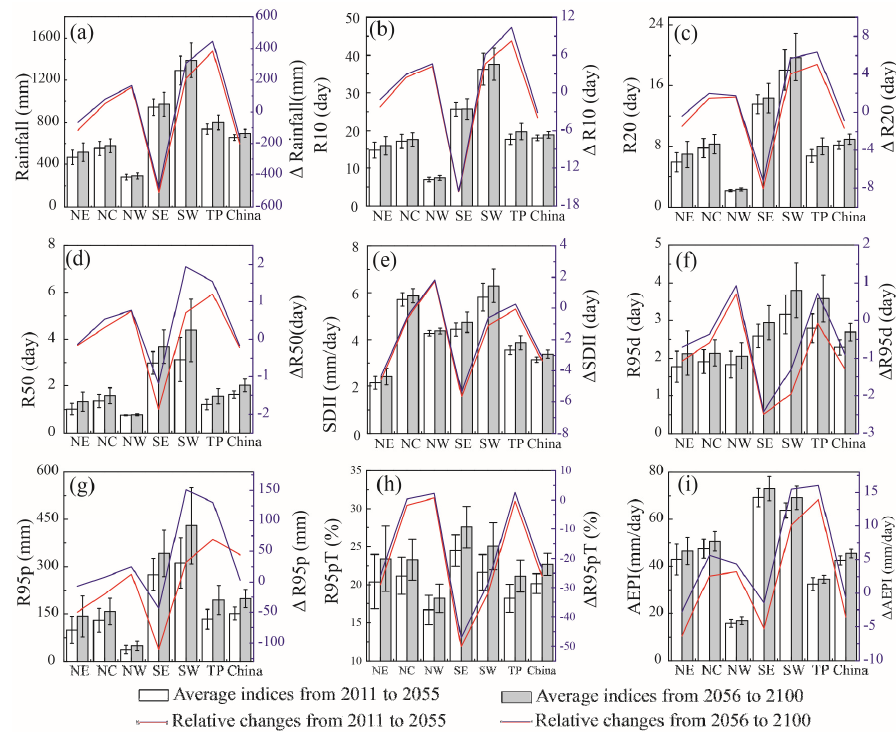
Figure 5. Annual average extreme precipitation indices in the next 90 years and the relative changes respect to the past 58 years (1960–2017) in China: ( a ) annual average rainfall, ( b ) annual average R10, ( c ) annual average R20, ( d ) annual average R50, ( e ) annual average SDII, ( f ) annual average R95d, ( g ) annual average R95p, ( h ) annual average R95pT, and ( i ) annual average in AEPI. The white bars represent the average indices from 2011 to 2055, and the gray bars indicate the average indices from 2056 to 2100. The red lines are the relative changes during the period 2011–2055 with respect to 1960–2017, and the blue lines are the relative changes in the period 2056–2100 with respect to 1960–2017.